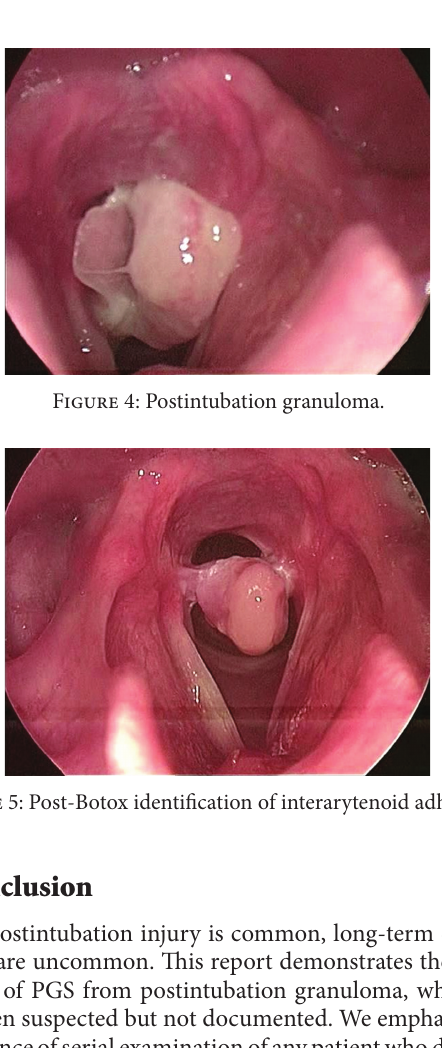
Figure 3: Mature posterior glottic granulation tissue and interarytenoid adhesion.